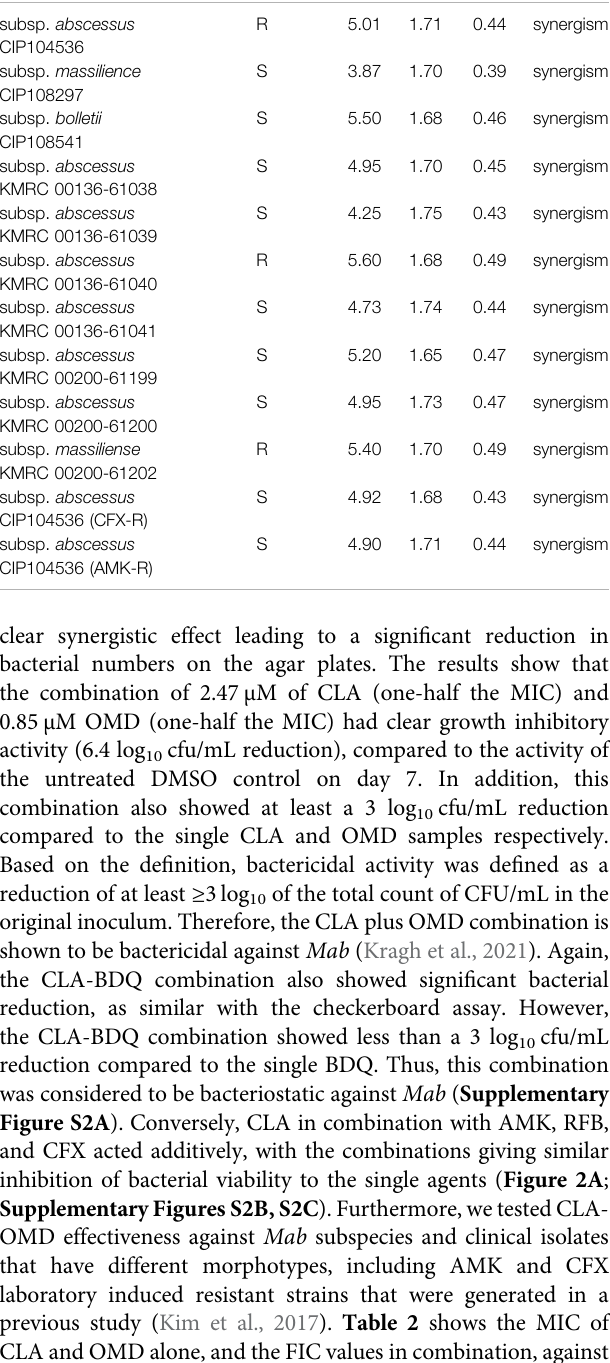
TABLE 2| MICsand interaction pro fi lesofclarithromycin(CLA) and omadacycline (OMD) against M. abscessus strains. Mab strains Colony